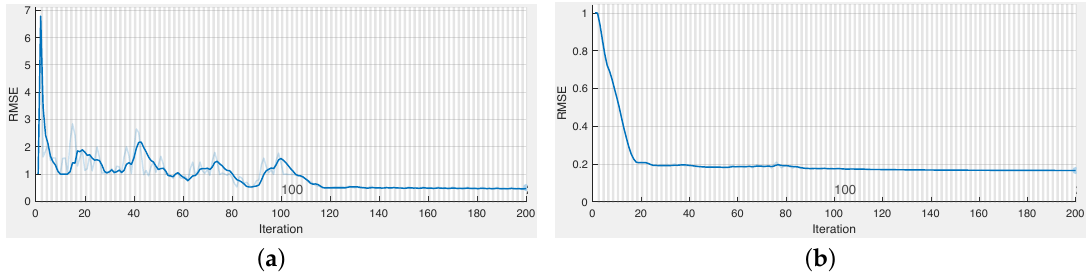
Figure 10. RMSE accuracy during training: Zurich. ( a ) Z-4 ( b ) Z-2.